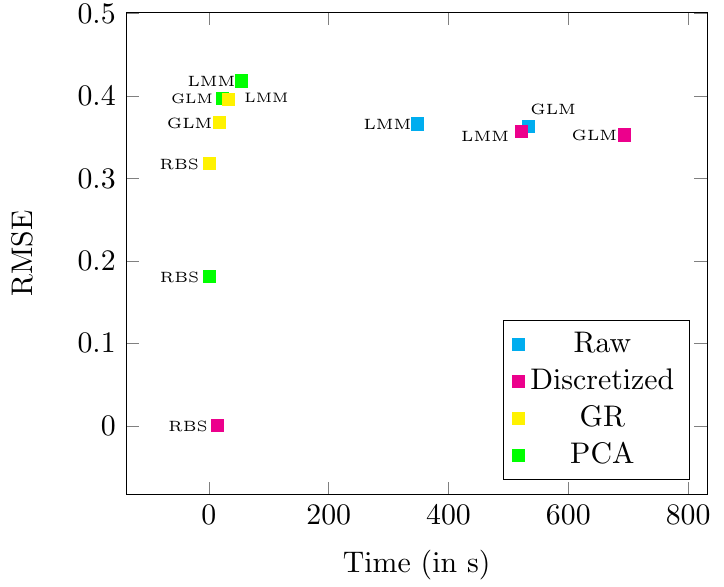
Figure 5. Relation between RMSE and